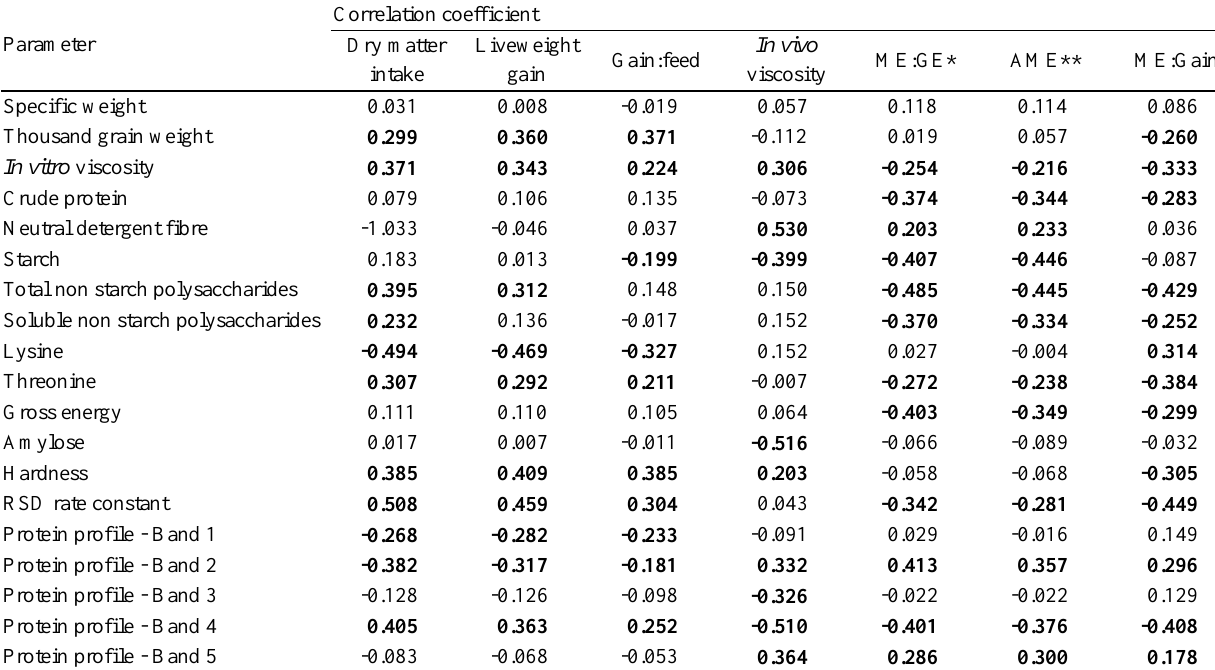
Table 4. a) Relationships between bird parameters and chemical and physical parameters of wheat